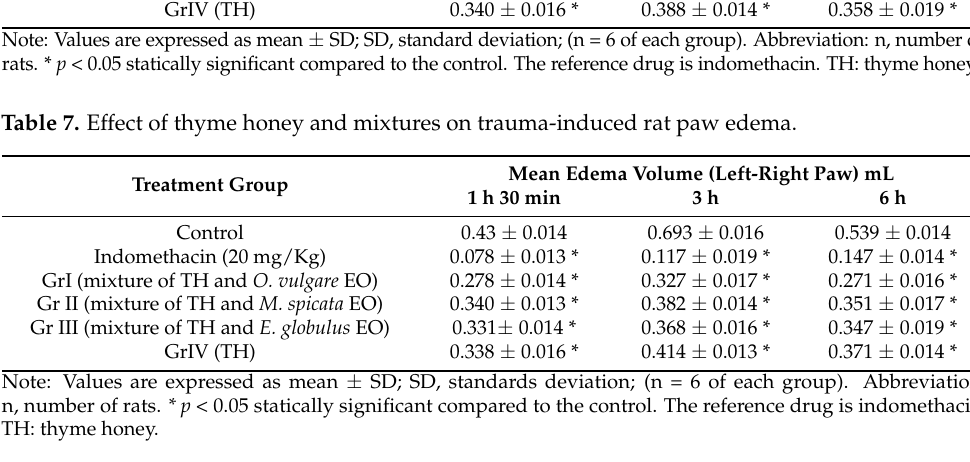
Table 8. Percentage inflammation inhibition by thyme honey and mixtures on carrageenan-induced rat paw